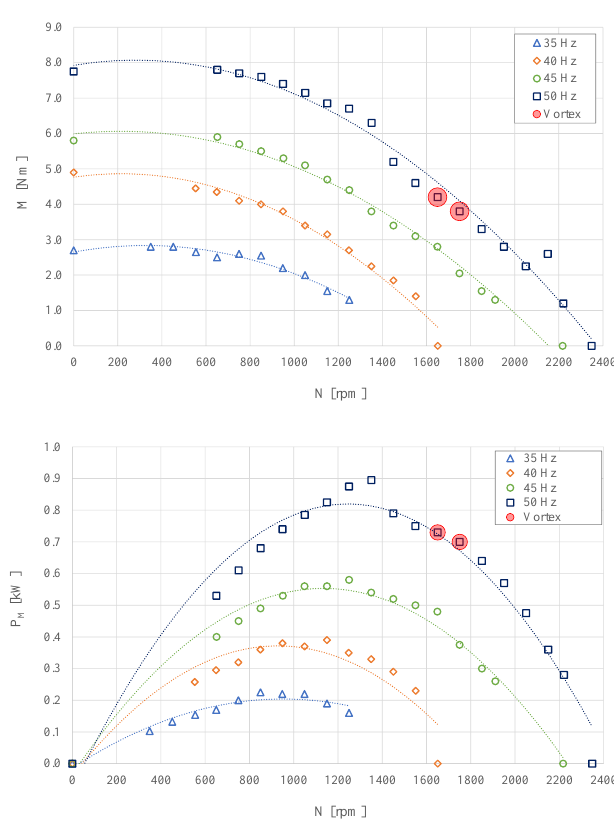
Figure 6. Curves of torque ( top ) and mechanical power ( bottom ) vs. rotational speed of the PAT, each referring to a specific frequency of the feed